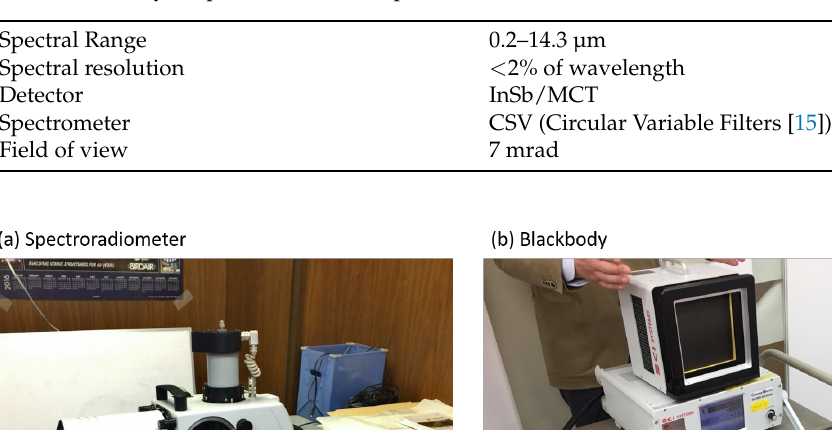
Table 1. Summary of spectroradiometer specifications.